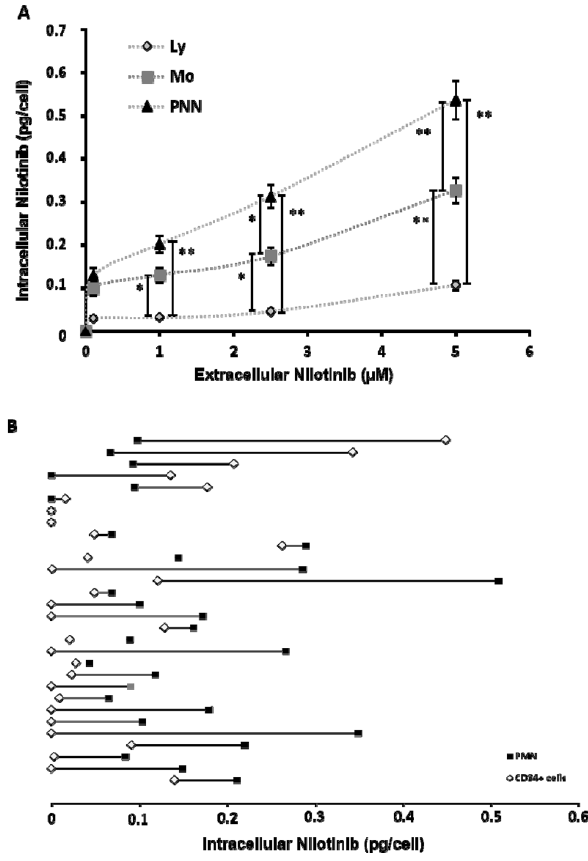
Figure 2. Nilotinib uptake in primary cells from patients with CML at diagnosis. ( A ) Nilotinib uptake by primary cells was evaluated by flow cytometry after 2 h of incubation with 0.1, 1, 2.5 or 5 µM of this TKI. Lymphocytes (Ly), monocytes (Mo), and polymorphonuclear cells (PMN) were identified on the basis of their FSC/SSC parameters. Nilotinib intracellular concentration was higher in PMN than in Ly and Mo (n = 60). Data are expressed as the mean ± standard deviation; the vertical bars indicate statistical comparisons, * P < 0.05, ** P < 0.001 ( B ) Nilotinib intracellular amount quantification after identification by flow cytometry of immature CD34 + cells and mature PMN cells within the same sample. Nilotinib concentration was significantly lower in CD34 + than PMN cells (n = 30; P = 0.019), and was undetectable in CD34 + and PMN cells from 12 (40%) and 4 (13.3%) samples,